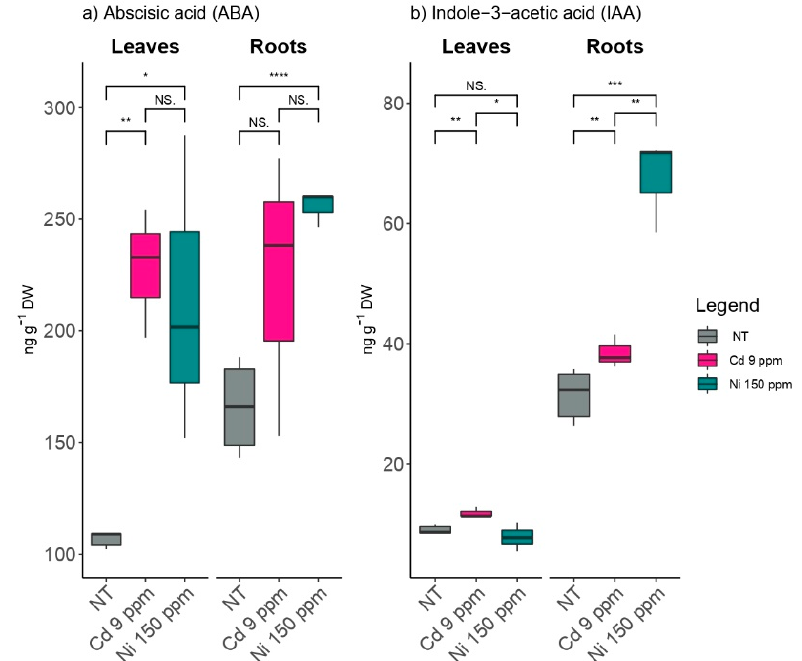
Figure 3. The effects of elevated Cd and Ni soil contents on amounts of plant hormones, (a) abscisic acid (ABA), and ( b ) indole-3-acetic acid (IAA) at root and leaf levels using NT-non treated soil. Cd 9 ppm-soil was supplemented to 9 mg Cd kg − 1 of soil DW and Ni 150 ppm-soil was supplemented to 150 mg Ni kg − 1 of soil DW. Significance levels: (NS) non-significant versus significant (*) < 0.05; (**) < 0.01; (***) < 0.001; and (****) < 0.0001.